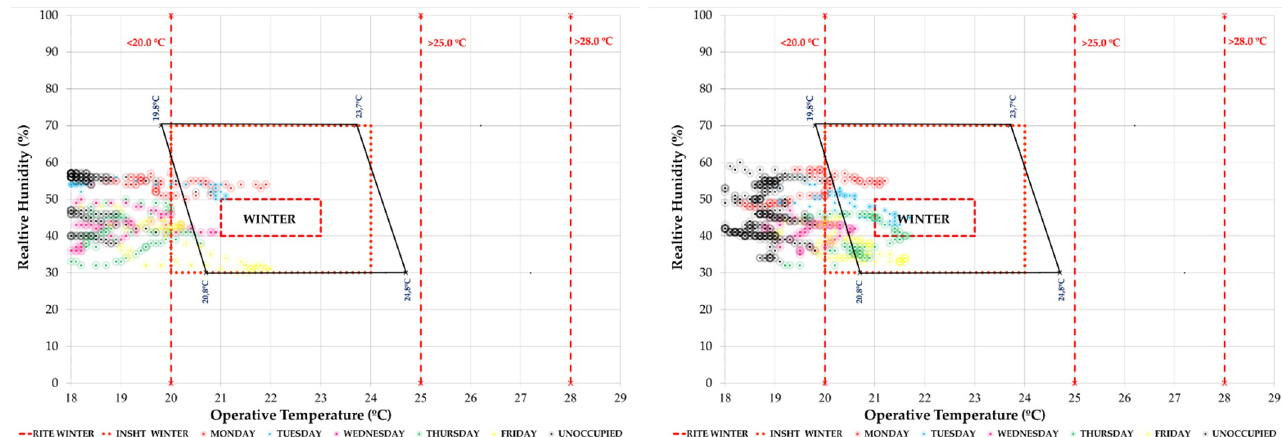
Figure 14. Indoor thermal comfort during the week 2020-11-30 to 2020-12-05 (Phase I) in classroom A 1.1 ( left ) and classroom A 2.1 ( right ). Source: authors.